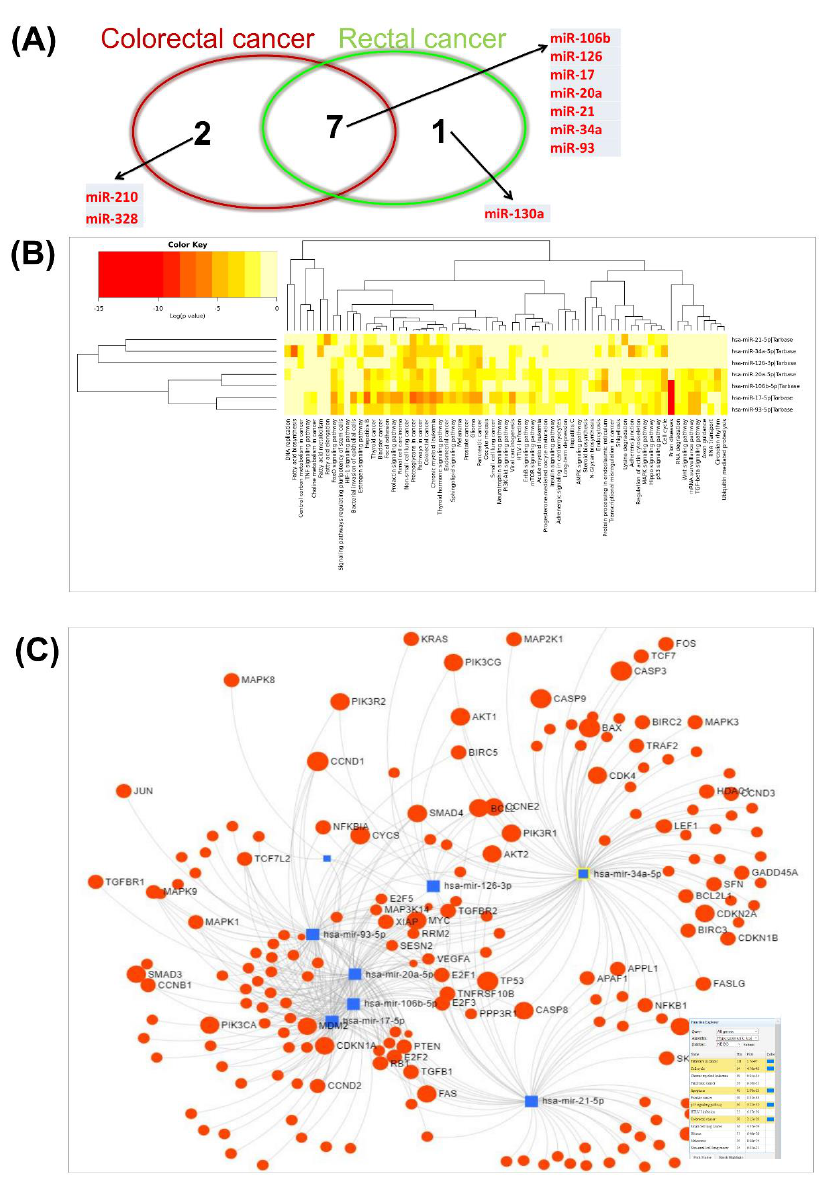
Figure 8. Plasma overexpressed miRNAs as key modulators of drug resistance observed to be altered in the cases of the analysis of colorectal and rectal cancer chemo-treated versus untreated. ( A ) Venn diagram for the altered miRNAs which are supposed to interfere with drug resistance in the analyzed groups. ( B ) Heatmap generated using DIANA-miRPath v3.0 (http: // snf-515788.vm.okeanos.grnet.gr), showing miR-21-5p, miR-34a-3p, miR-126-3p, miR-20a-5p, miR-106-5p, miR-17-5p and miR-93-5p targets associated with biological processes. ( C ) miRNET network for common miRNA signatures emphasizing an important number of target genes related to pathways in cancer and TP53